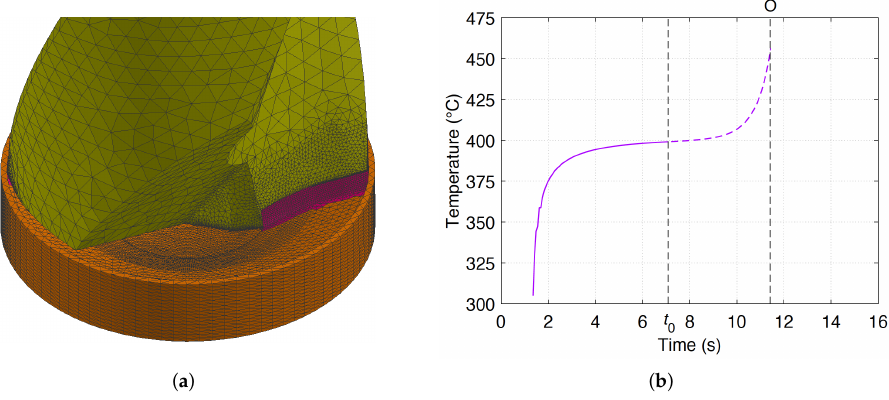
Figure 12. Average temperature θ in the cutting zone: ( a ) cutting zone’s mesh in purple; and ( b ) time evolution.